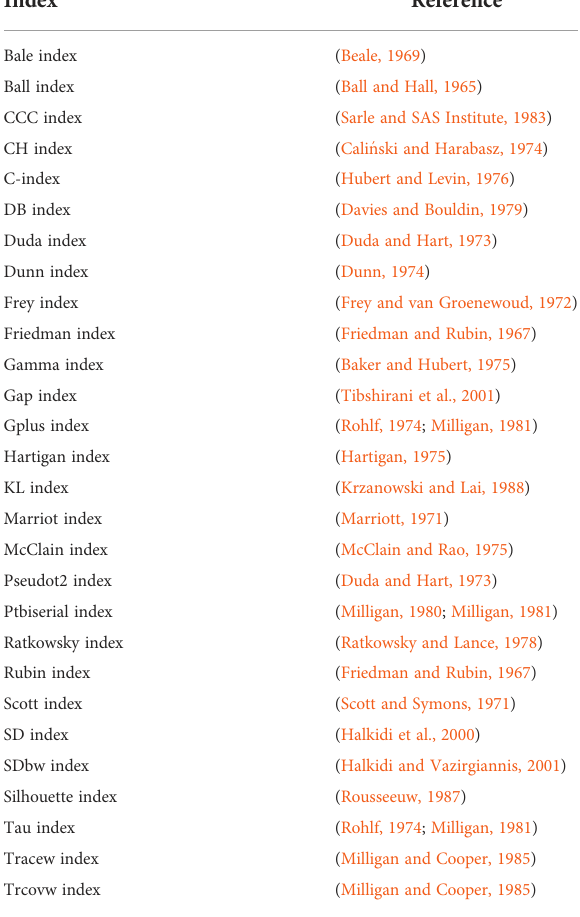
TABLE 1 Indices used to determine the optimal number of